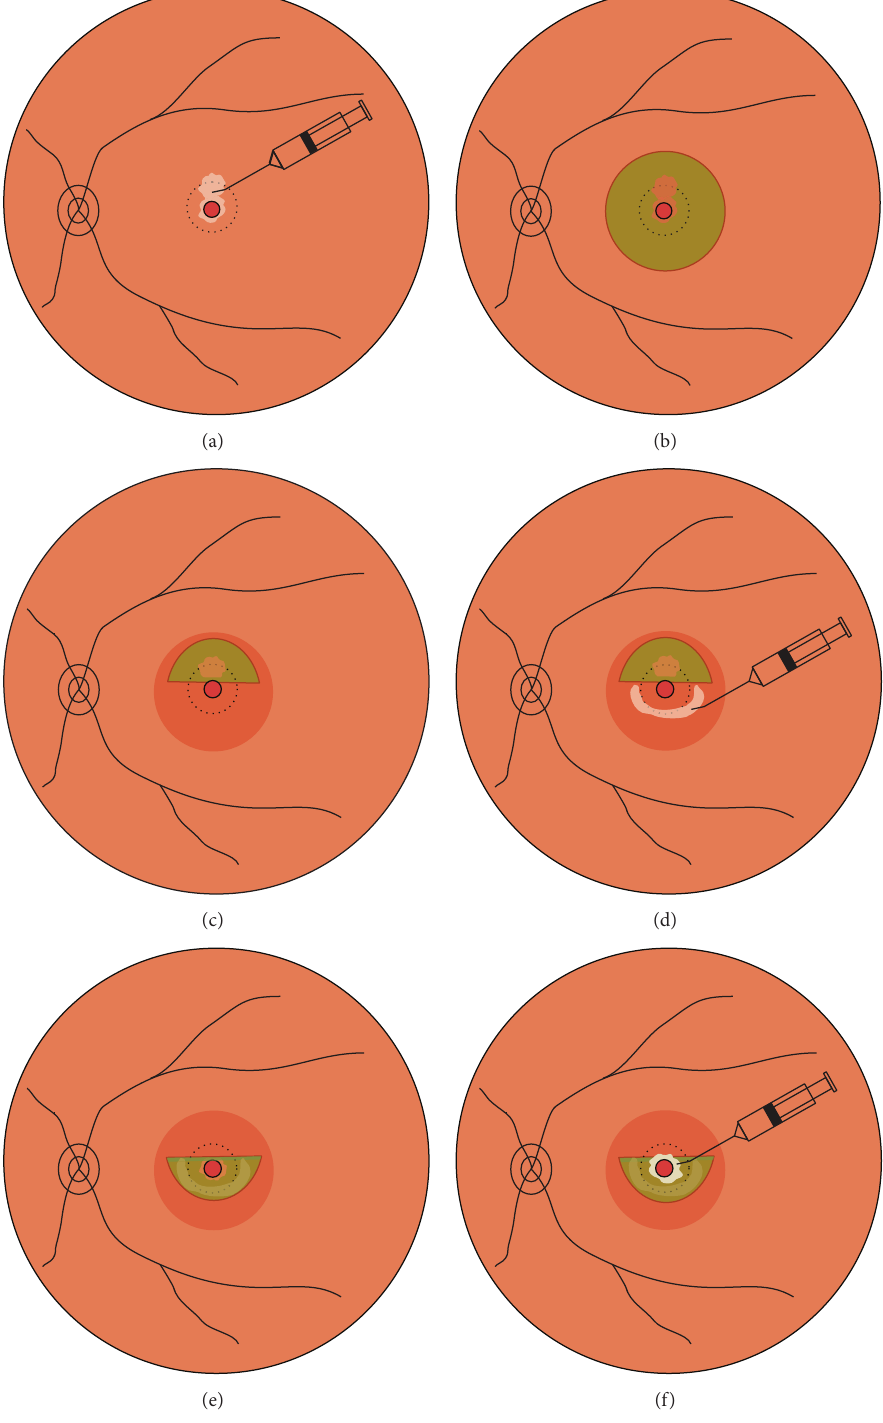
Figure 1: Schematic drawings showing the Viscoat assisted single-layered inverted internal limiting membrane (ILM) flap technique. (a) After performing a 23-gauge 3-port pars plana vitrectomy, Viscoat is injected into the macular hole (MH) and its mirror symmetrical area superior to MH. (b) Indocyanine green (ICG, 0.125% solution) is then applied around the MH within the arcade to stain the ILM. Excessive ICG as well as Viscoat is removed by suction. (c) The ILM is peeled off in a circular fashion for approximately 2.5 disc diameters around the MH. The inferior ILM is completely peeled off, while the superior ILM is not removed completely but left attached to the edge of the MH, forming an ILM flap of about 1 disk diameter. (d) Viscoat is injected and smeared in an arch around the MH in the lower half part of the macular as an adhesive. (e) The ILM flap is flipped by inverting it using the intraocular forceps to cover the whole MH and gently massaged to make it flattened. (f) Supplementary Viscoat is applied on top of the inverted ILM flap as ballast before air-fluid exchange is